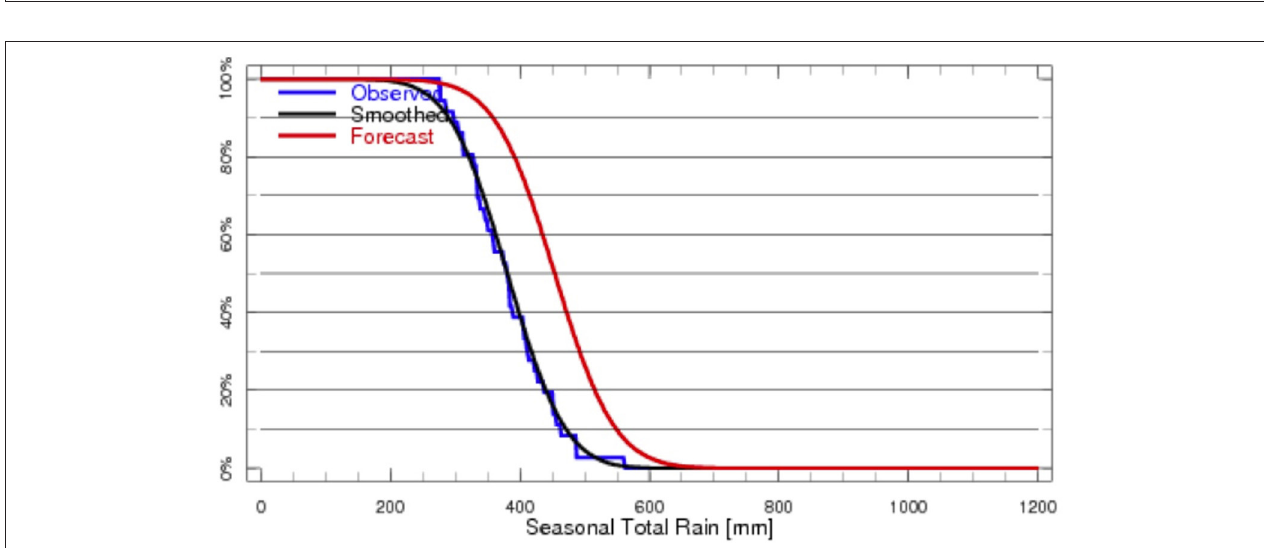
FIGURE 10 | Drilling down to a specific location: the probability that next season’s rainfall total will exceed a range of values (exceedance probability), comparing the forecasted (red) with what is normally expected for that location (blue).